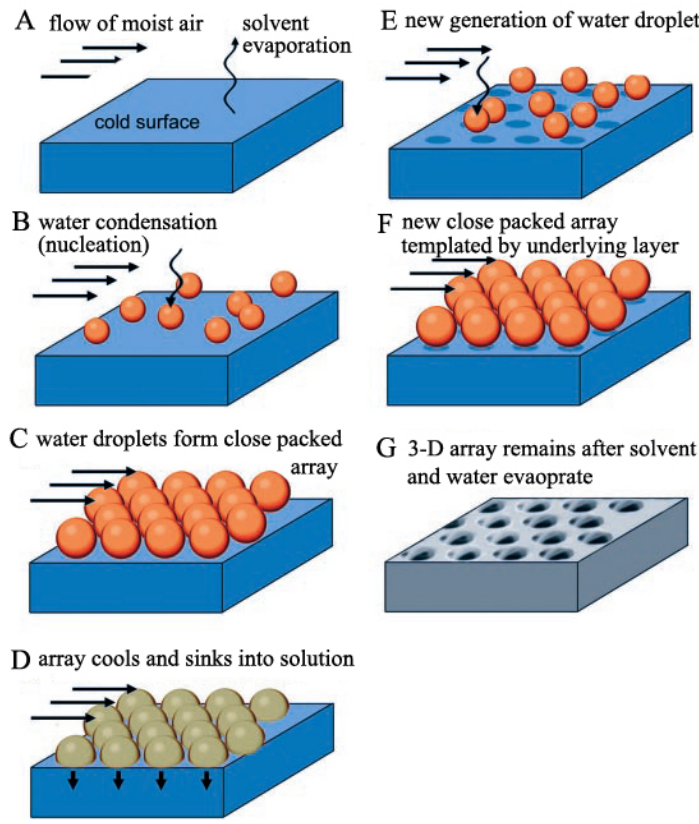
Figure 2. Illustration of the ordered honeycomb structure formation mechanism proposed by Srinivasarao. ( A ) solvent evaporation leads to the cold polymer solution surface; ( B ) water condenses on cold surface to become water droplets, which is the nucleation process; ( C ) water droplets from close packed array because of the convective currents of the evaporation and moist air flow; ( D ) water droplet array cools and sinks into solution; ( E ) new generation of water droplets; ( F ) new close packed array template by underlying layer; ( G ) 3-D array remains after solvent and water evaporation, which means the ordered honeycomb pores formation. The copyright permission was from reference